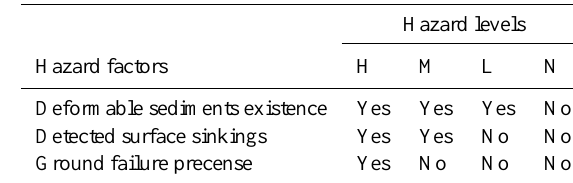
Table 2. Hazard factor array and resulting hazard levels. H: High level, M: Medium level, L: Low level, N: non-existent